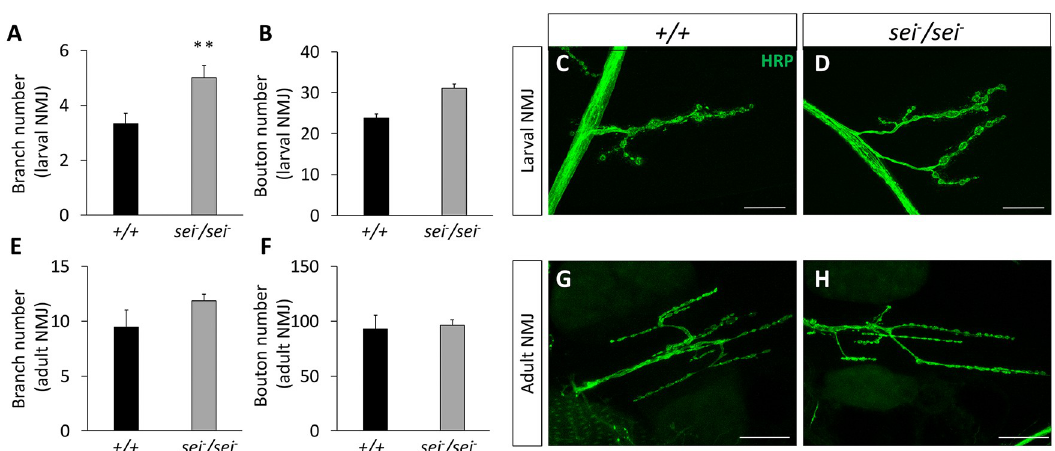
Fig 7. Effects of sei mutation on NMJ synaptic morphology in larvae and adults. A ) SeiP mutants display increased branching at the larval neuromuscular junction (NMJ). n = 11–12. B ) No difference in the number of boutons was observed between seiP mutants and controls at the larval NMJ. n = 11-12/genotype. C-D ) Representative 63x confocal z-stack images of larval NMJs stained with anti-HRP antibody labeling neuronal processes. E-F ) No differences were observed in number of branches or bouton number at the NMJ of adult ventral abdominal muscles. n = 7/genotype. G-H ) Representative 63x confocal z-stack images of adult abdominal NMJs stained with anti-HRP antibody labeling neuronal processes. Data are presented as mean ± SEM, �� p < 0.01 (Student’s t -test). Scale bars are 20 μ